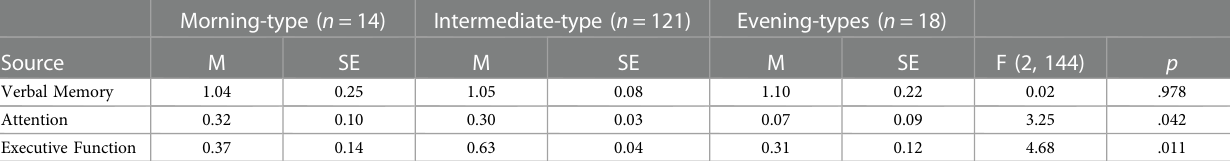
MANCOVA model predicting verbal memory, attention, and executive function factor scores from chronotype, controlling for covariates (age, sex, education, BMI, discrepancy between sleep midpoint and time of cognitive testing, and VM CPM). VM CPM, vector magnitude counts per minute; BMI, body mass index.